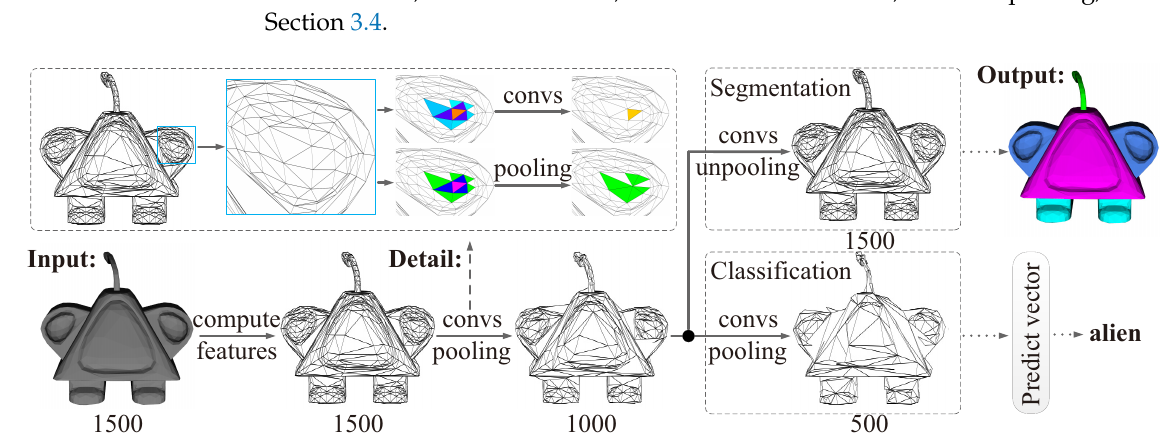
Figure 2. An overview of our framework for segmentation and classification, where the bottom of the model is the number of faces.